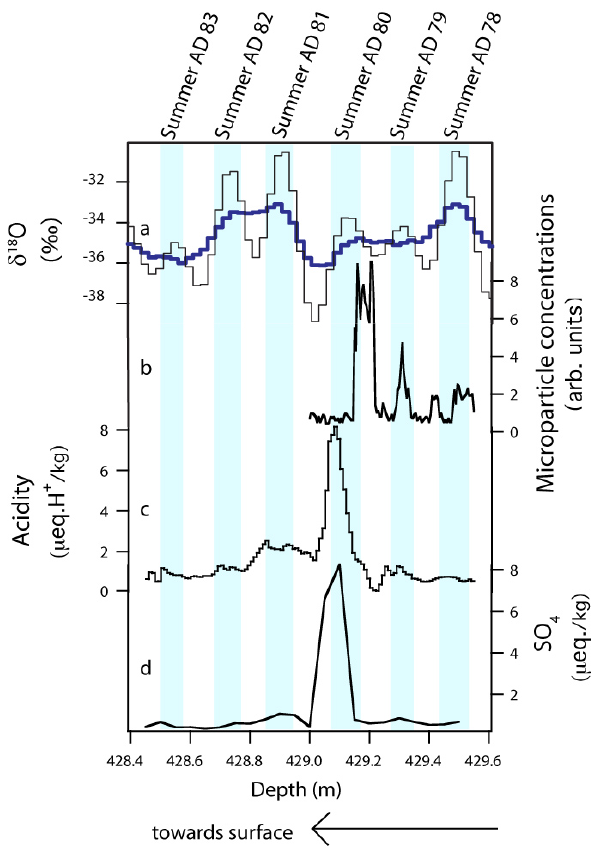
Fig. 2. High resolution δ 18 O, microparticle, acidity, and sul- fate concentrations from 428–430m in the GRIP ice core. The blue bars highlight δ 18 O peaks ascribed to summer accumulation. The ages are from the GICC05 annual layer counting, but off- set by one year to conform with the Vesuvian ( August 79AD ) tephra layer detected at 429.3m. The “arbitrary units” for the dust concentrations were determined by calibrating the signal from the laser device to Coulter counter results to obtain an ar- bitrary scale where 1.0mV = 50 ± 15 microgramskg − 1 dust and 8mV = 400 ± 130microgramskg − 1 dust (ash). The error associ- ated with the dust curve is ± 30%.